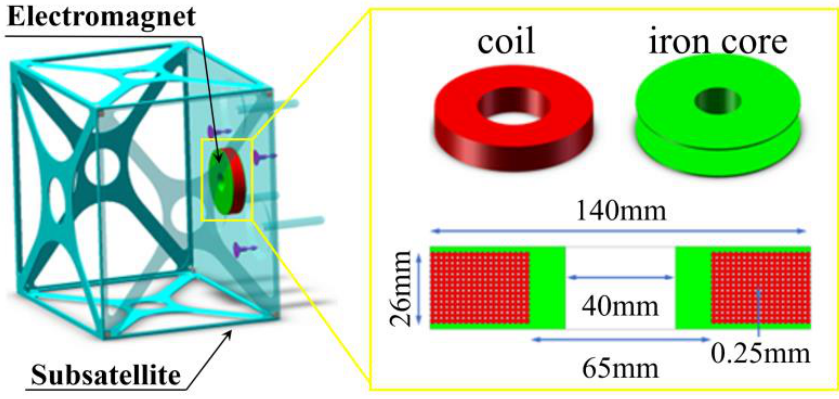
Figure 1. Schematic diagram of the electromagnetic assisted docking mechanism.